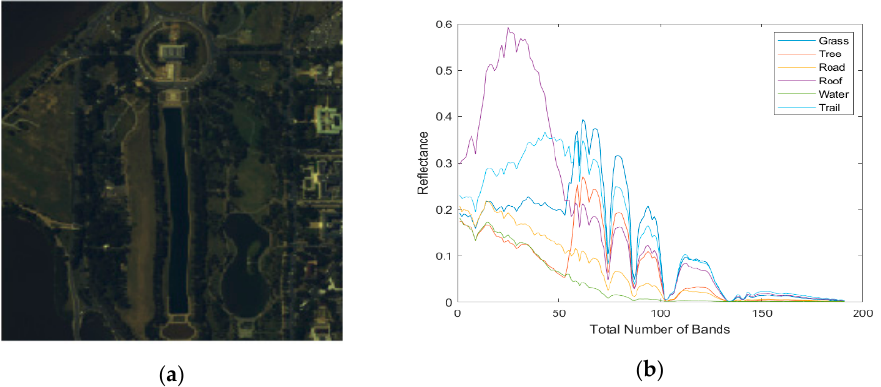
Figure 14. Washington DC Mall hyperspectral image. ( a ) Color image. ( b ) Endmembers.